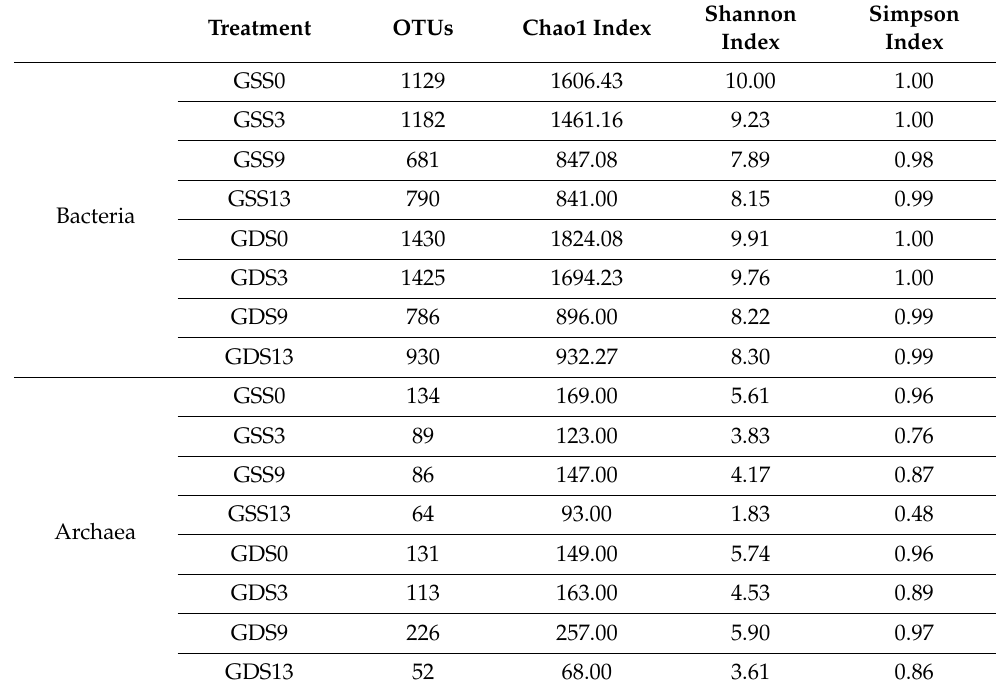
Table 3. Statistics of different planting years on the abundance and diversity of soil bacteria and